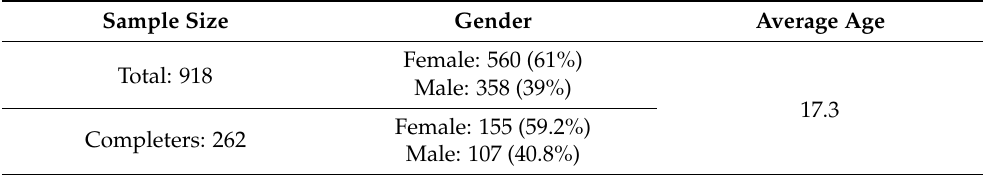
Table 1. Demographic characteristics of the sample used for this study in the department of Antioquia. Sample